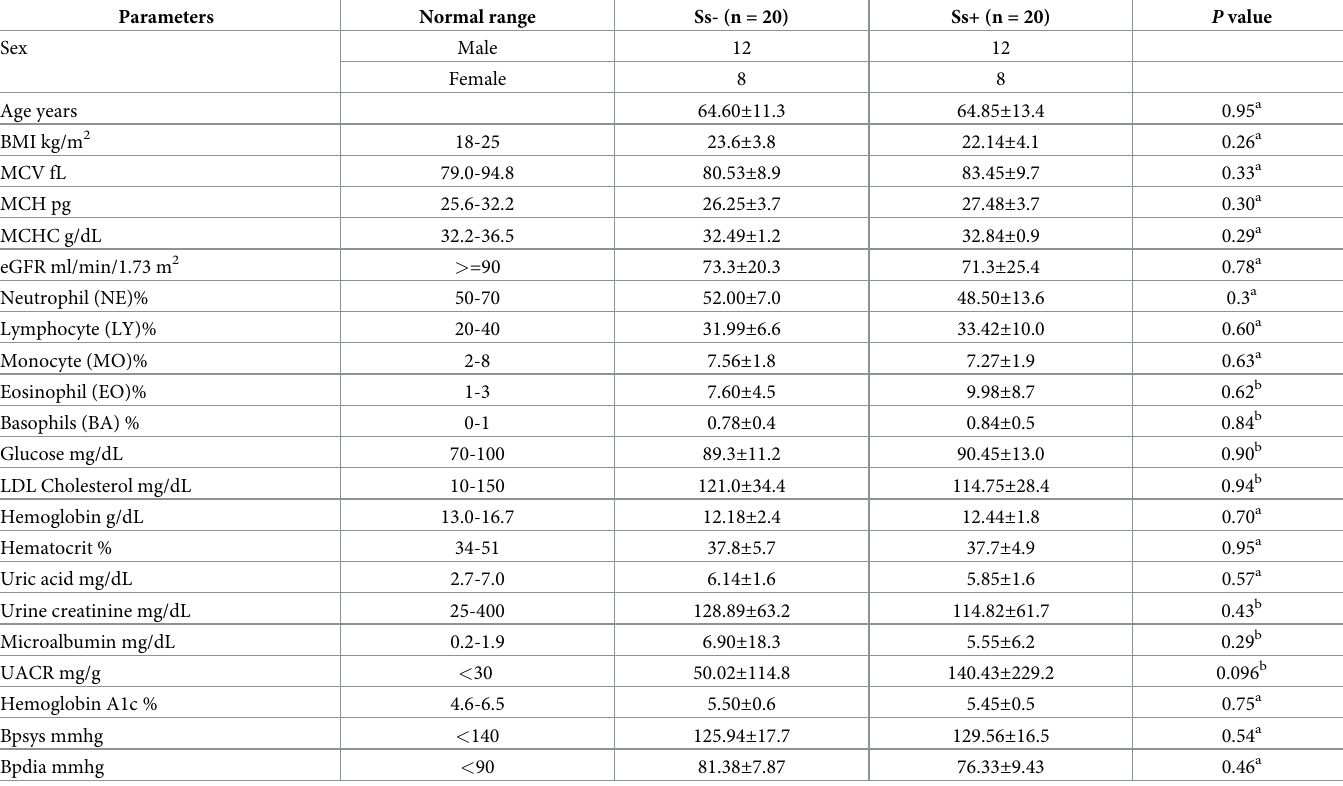
Table 1. Characteristics of chronic kidney disease patients.